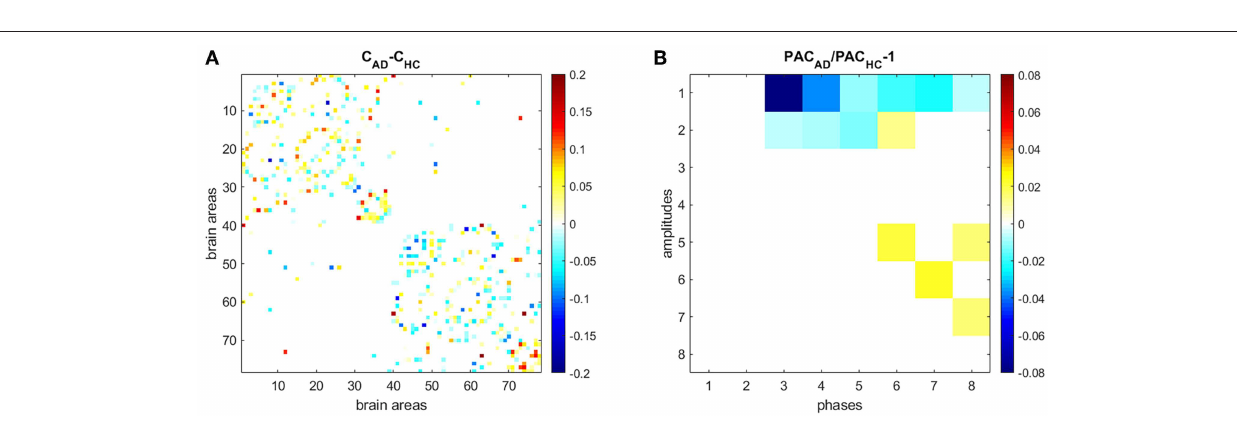
both groups the two areas with the strongest influence were the right superior frontal followed by the right medial